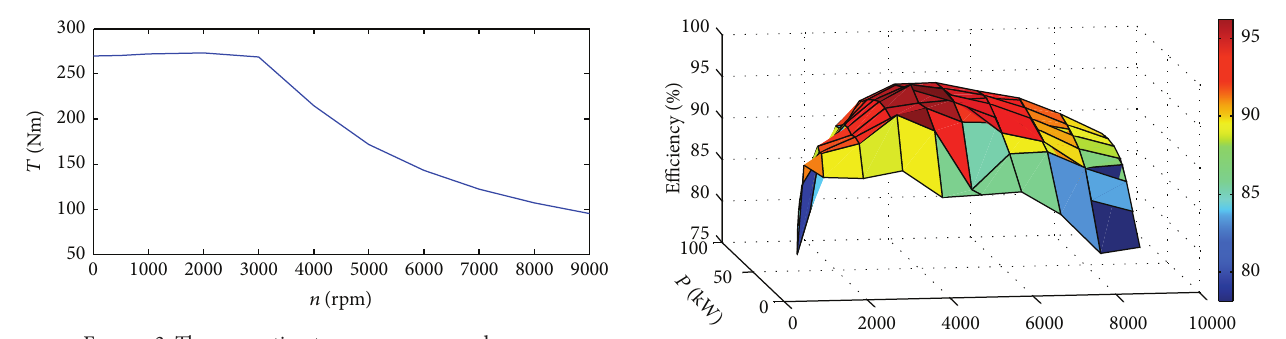
Figure 3: The generating torque versus speed curve. torque characteristics of motor. The other is the maximum input charging torque of the battery, which is restricted by the current state of charge (SoC).